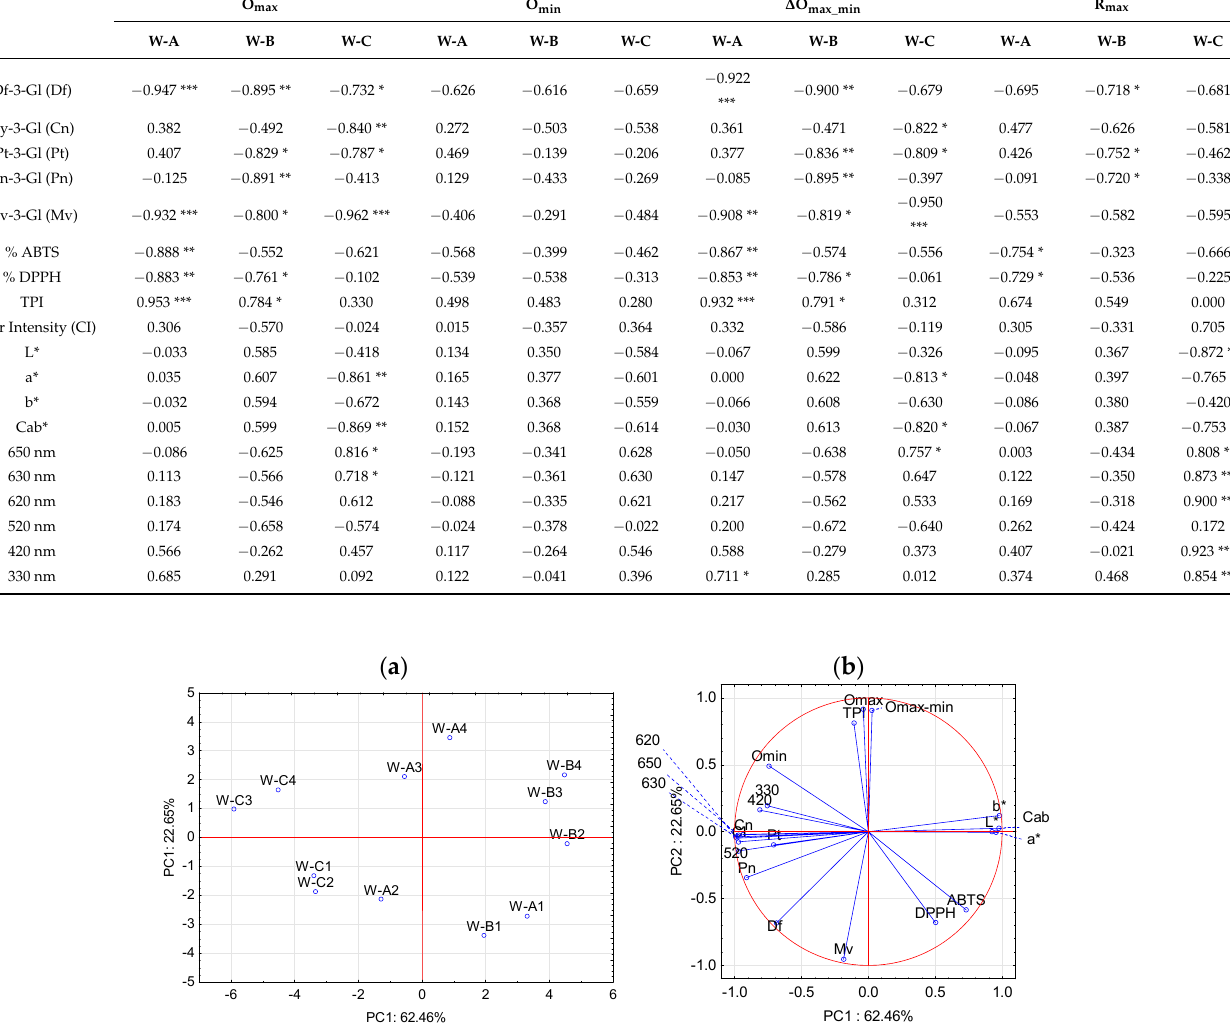
Figure 4. Principal component analysis (PCA) for W-A, W-B, and W-C presents distribution of the samples ( a ) and of the variables ( b ) (Legend in Table 2).